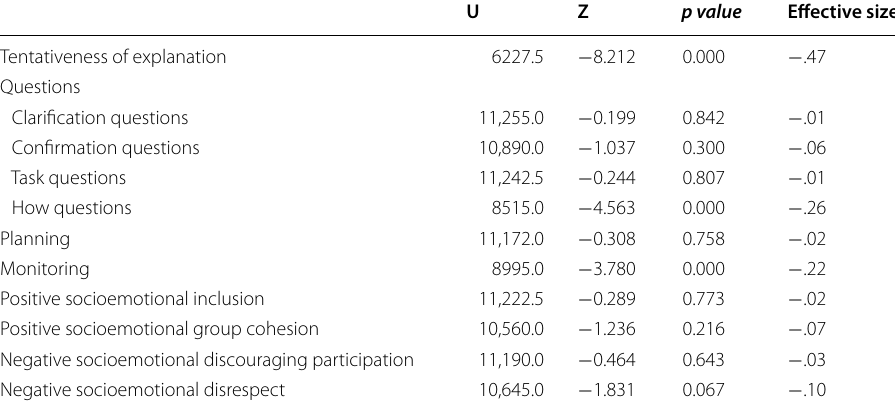
Table 4 Mann–Whitney test between high- and low-level content co-regulation episodes U Z p value Effective size Tentativeness of